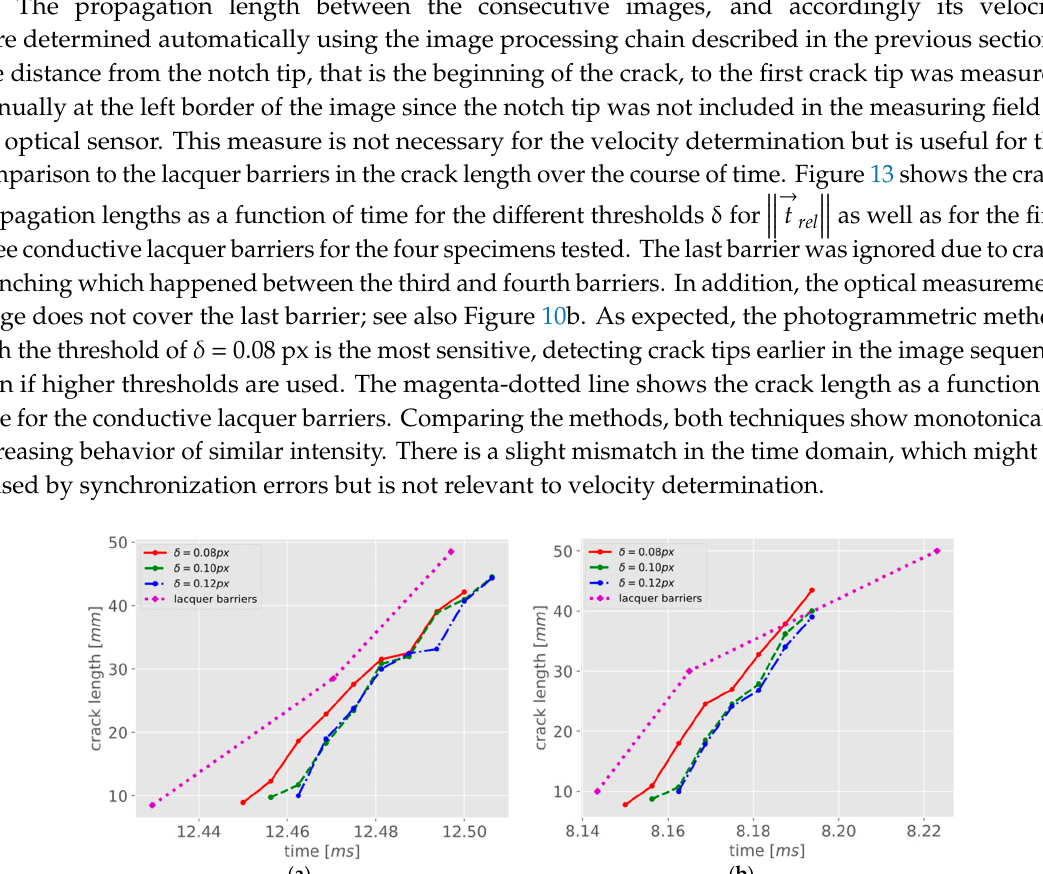
mesh border triangles for the experiment presented in Figure 11.